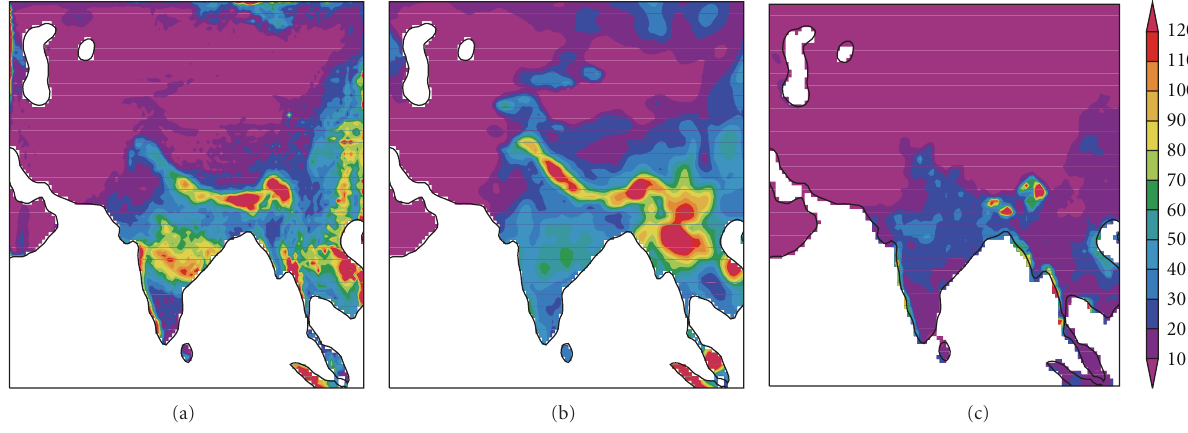
Figure 11: Standard deviation of precipitation (mm; shaded) for HIRHAM (a), ERA40 (b), and GPCC4 (c); summer monsoon (JJAS)